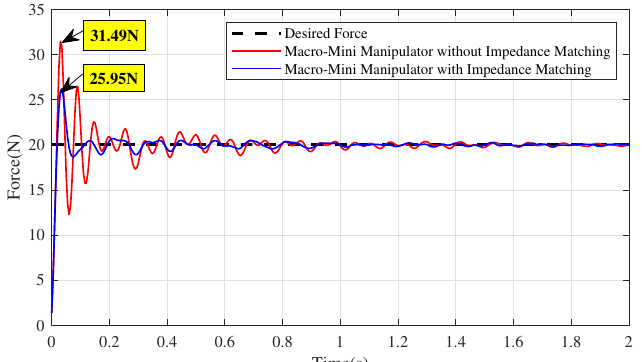
Figure 10. Result of direct force control.